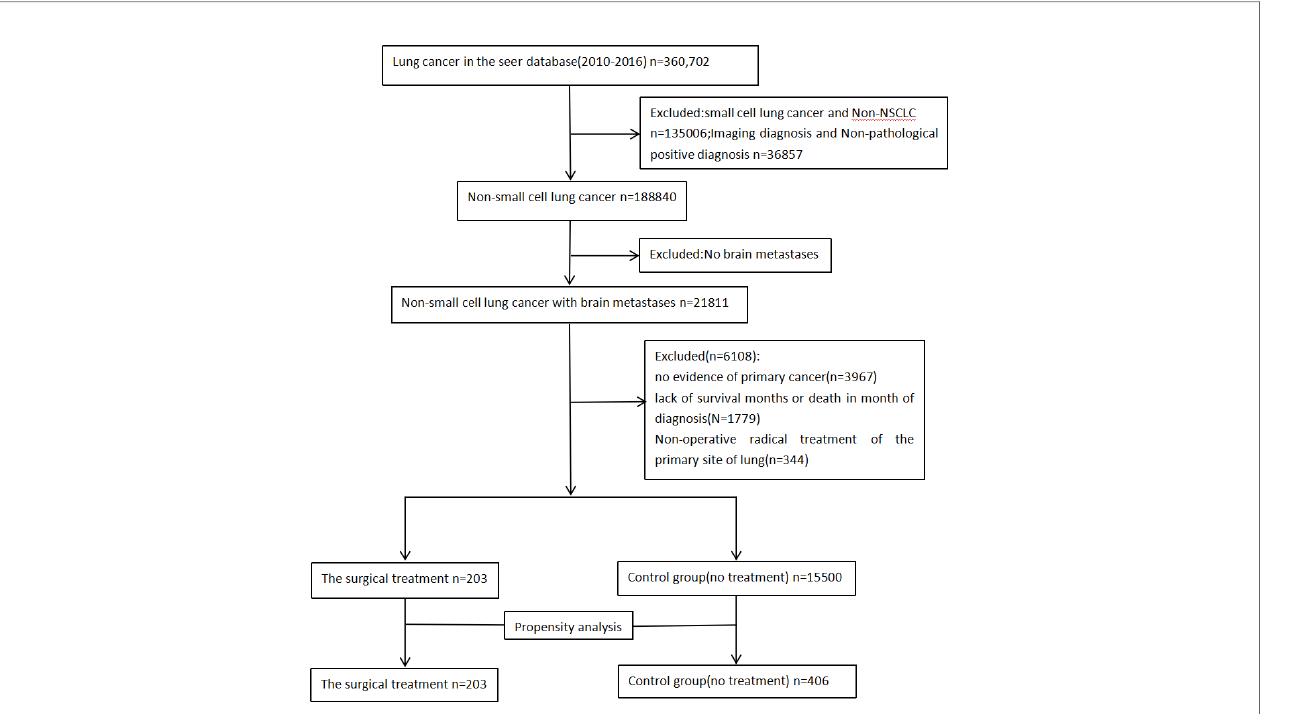
FIGURE 1 | SEER Data extraction and fi ltering fl